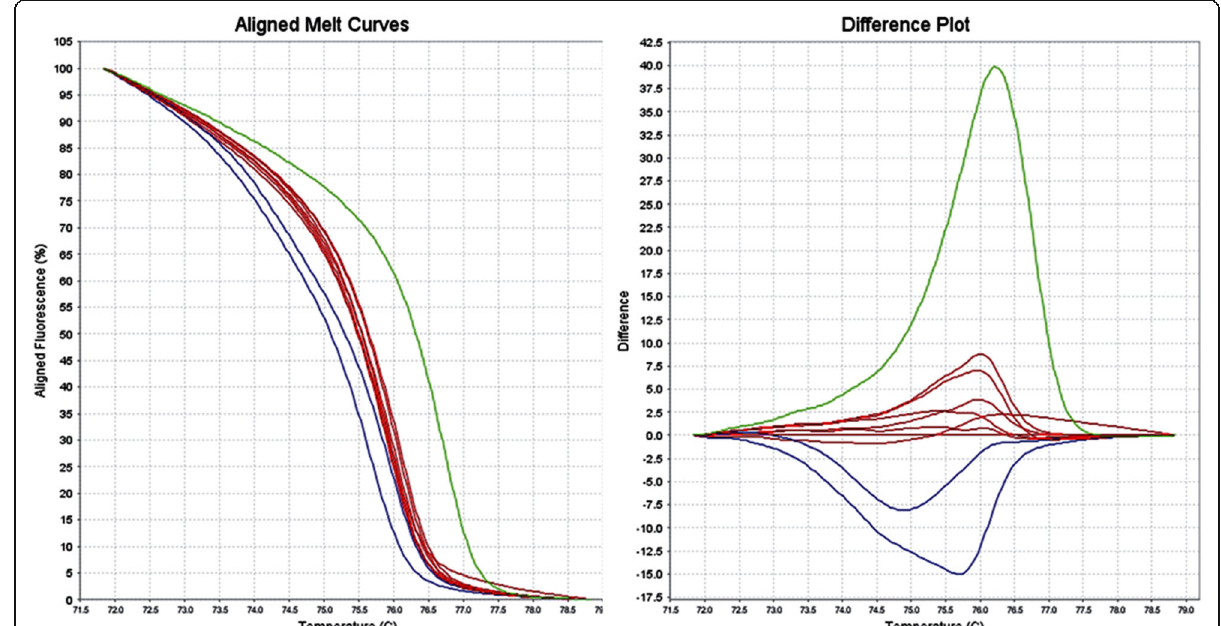
Fig. 1 HRM difference plot curve and aligned melting curve of NPM1 . The wild genotype cases (red) and there are two mutant cases (blue and green)